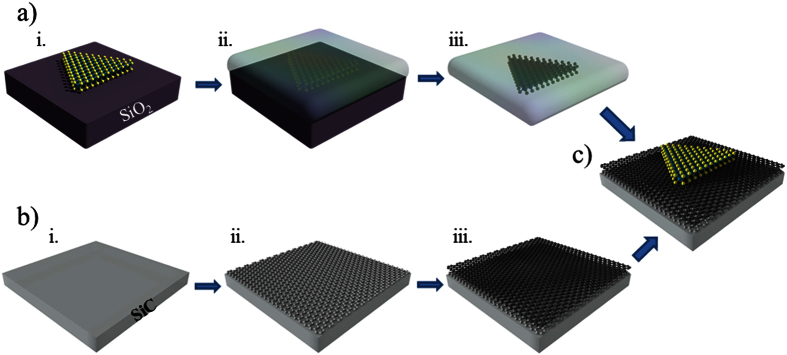
Schematic transfer process of MoS2 on epitaxial grapheme:
(a) i. Growth of MoS2 on Si/SiO2. ii.
Coating of PMMA on the top of the sample iii. KOH etching of SiO2
substrate. (b) i. 4H-SiC substrate. ii. Interface layer. iii.
Monolayer epitaxial Graphene. (c) Monolayer MoS2 on
epitaxial grapheme.